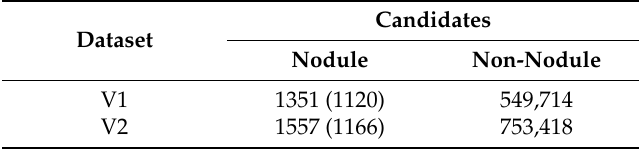
Table 1. Statistics of the dataset in the Lung Nodule Analysis 2016 (LUNA16) challenge. The number in parentheses indicates the number of nodule-labeled matches with 1186 real nodules.